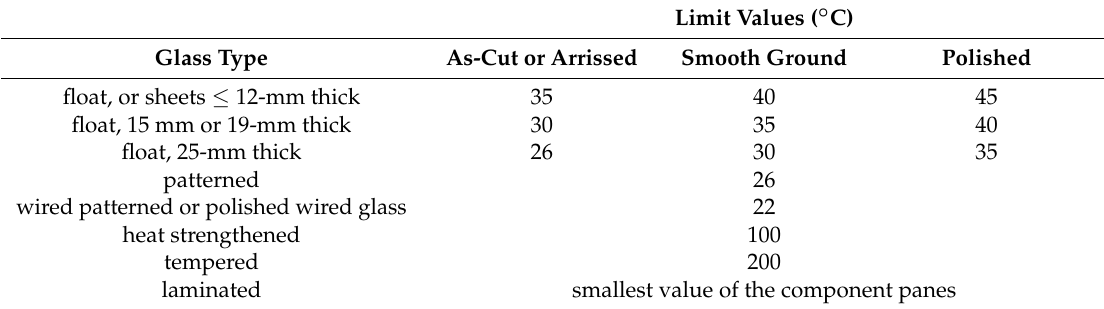
laminated smallest value of the component